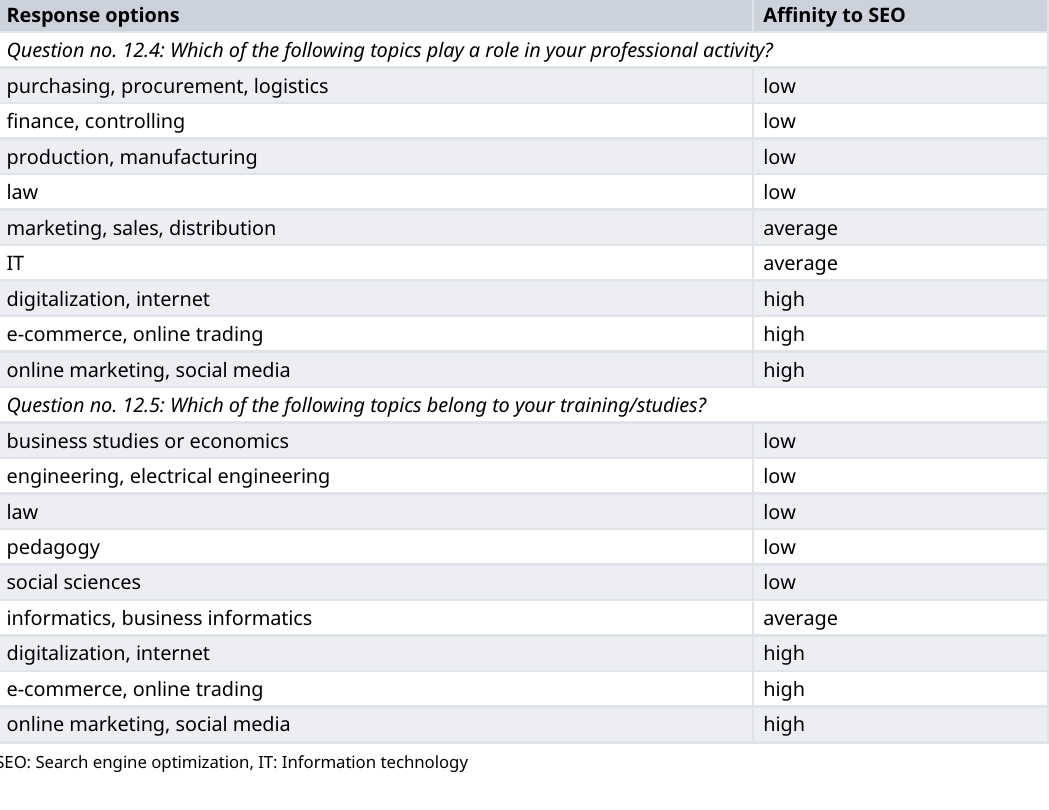
Table 5. Marking tasks: results to be marked.